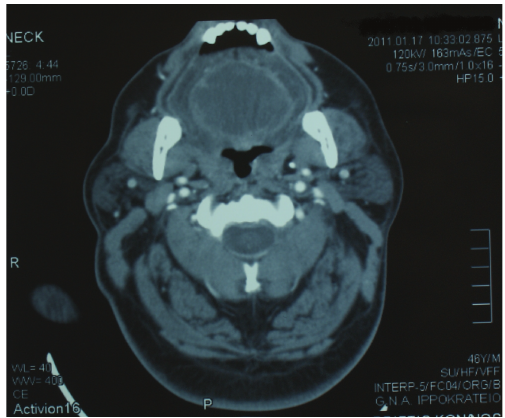
Figure 1: Computed tomographic evidence of a circumscribed mass within the tongue musculature, compatible with a lingual